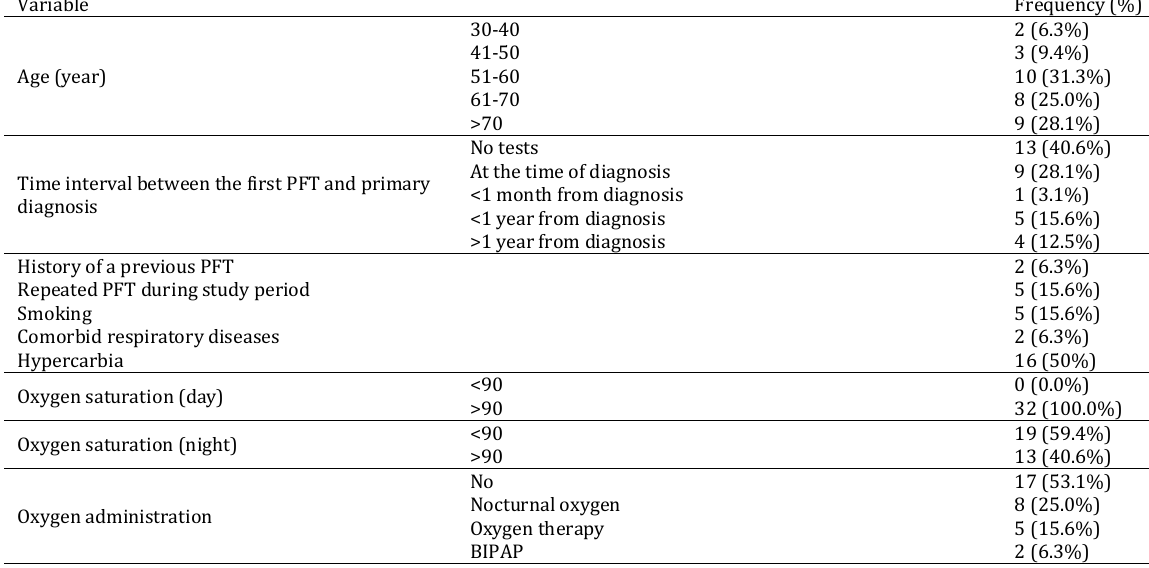
Table 1 . Demographic and laboratory characteristics of the study population Variable